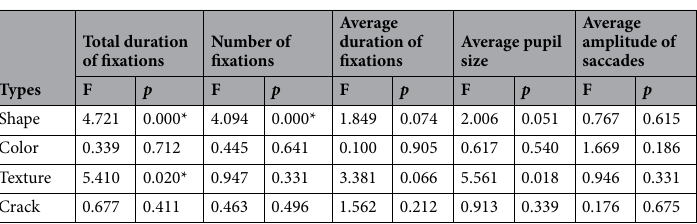
Table 5. ANOVA results of eye movement indexes of different types of leaves. *Indicating that there is a difference in the index of this feature.